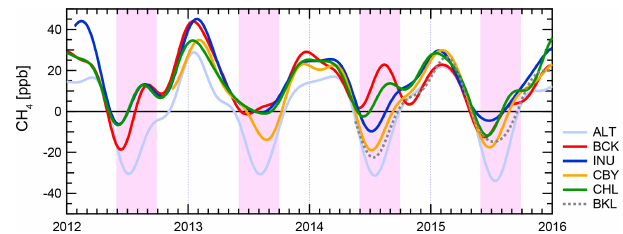
Figure 3. Seasonal components in fitted curves of observed atmo- spheric CH 4 mixing ratios at Canadian Arctic sites. Each fitted curve has subtracted the long-term trend component of Alert. Sum- mer months (June-September) are highlighted as light pink